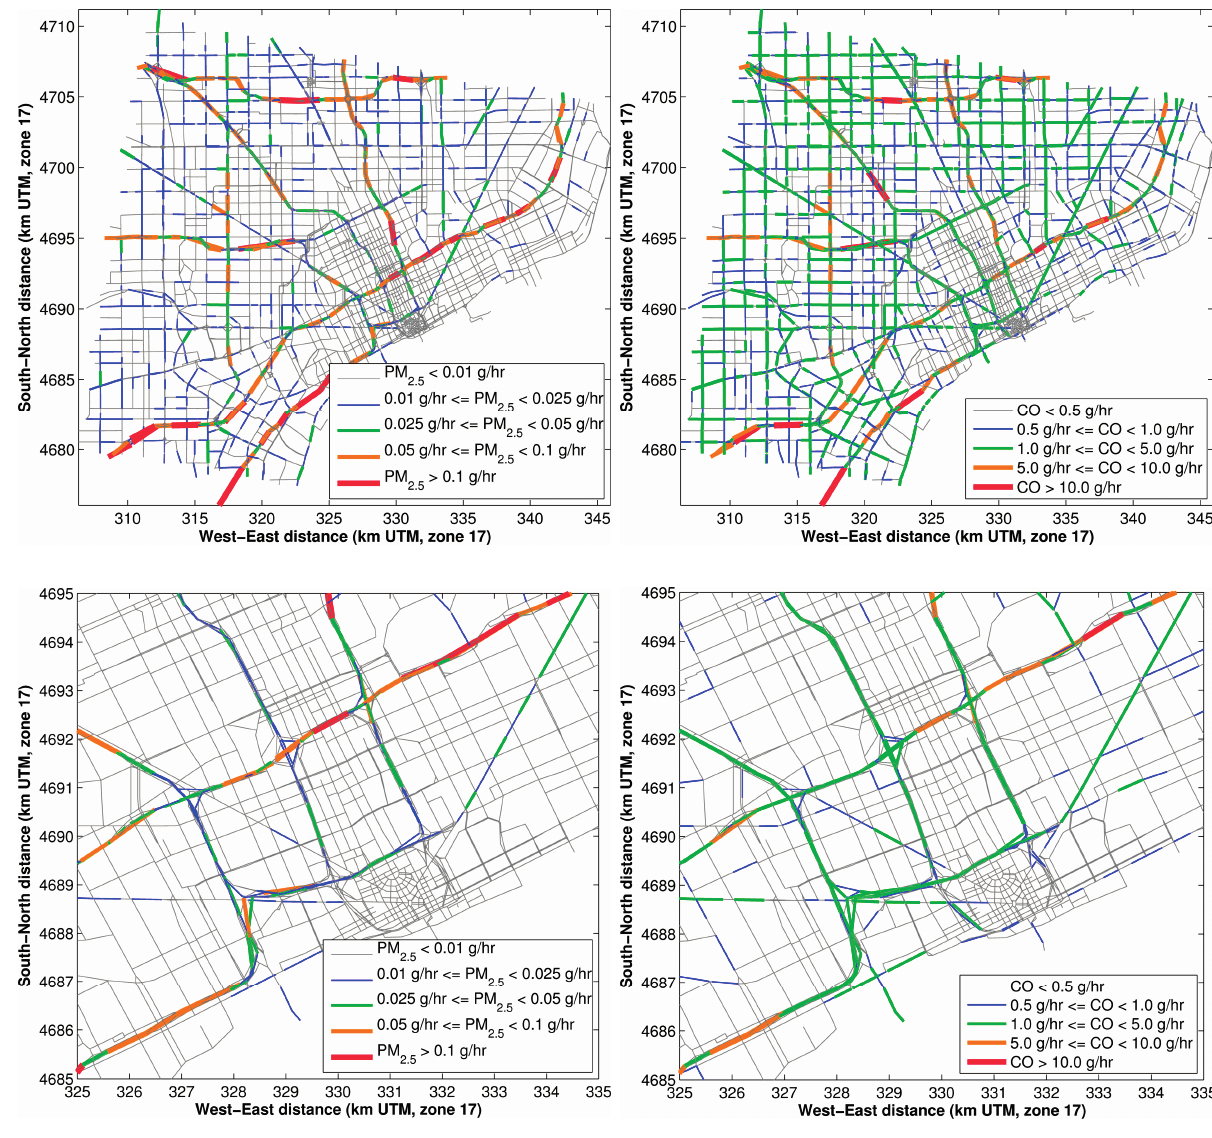
Figure 3. Emissions results (in g/h) for Detroit road links for an average AM-peak hour in August 2010: emissions of PM (top panels) and of CO (bottom panels). The right-hand 2.5 panels show an enlargement of